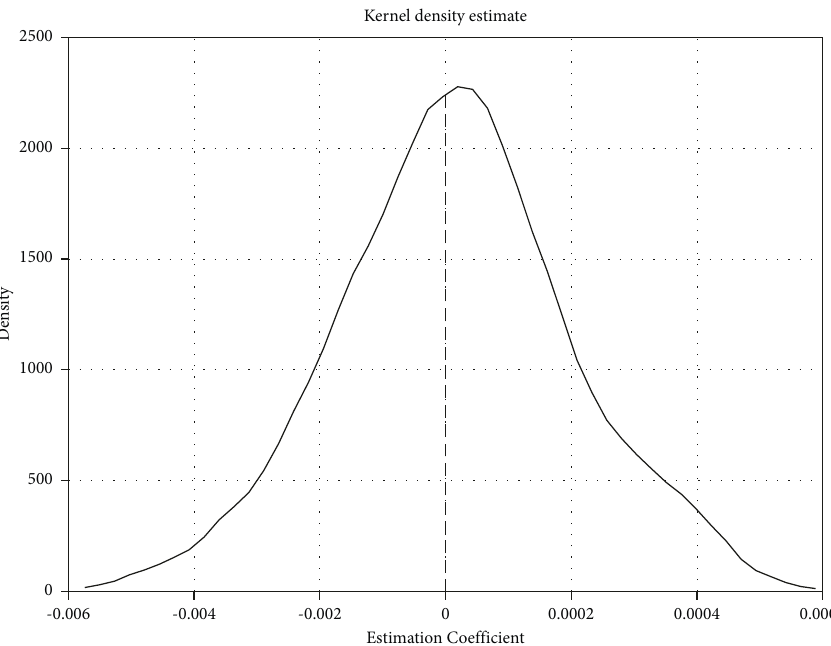
Figure 2: Distribution of the stochastically processed t .